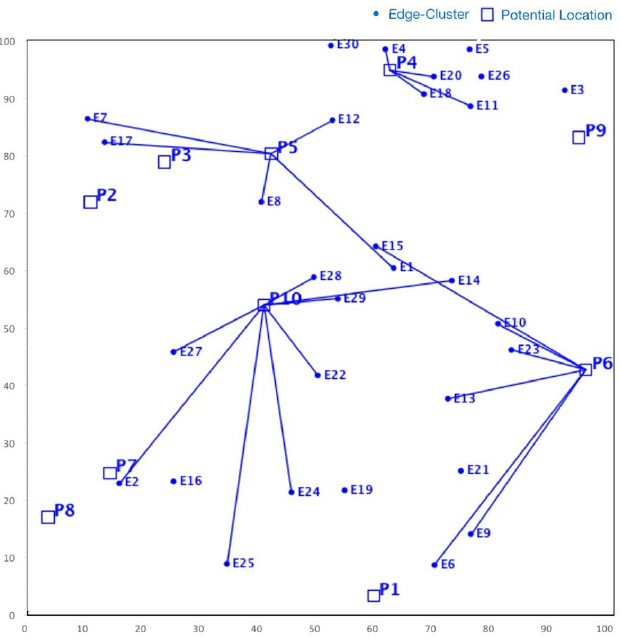
Figure 11. Output layout for CPLEX at e avg v = 77.31 units, τ avg v 321.9 ms.